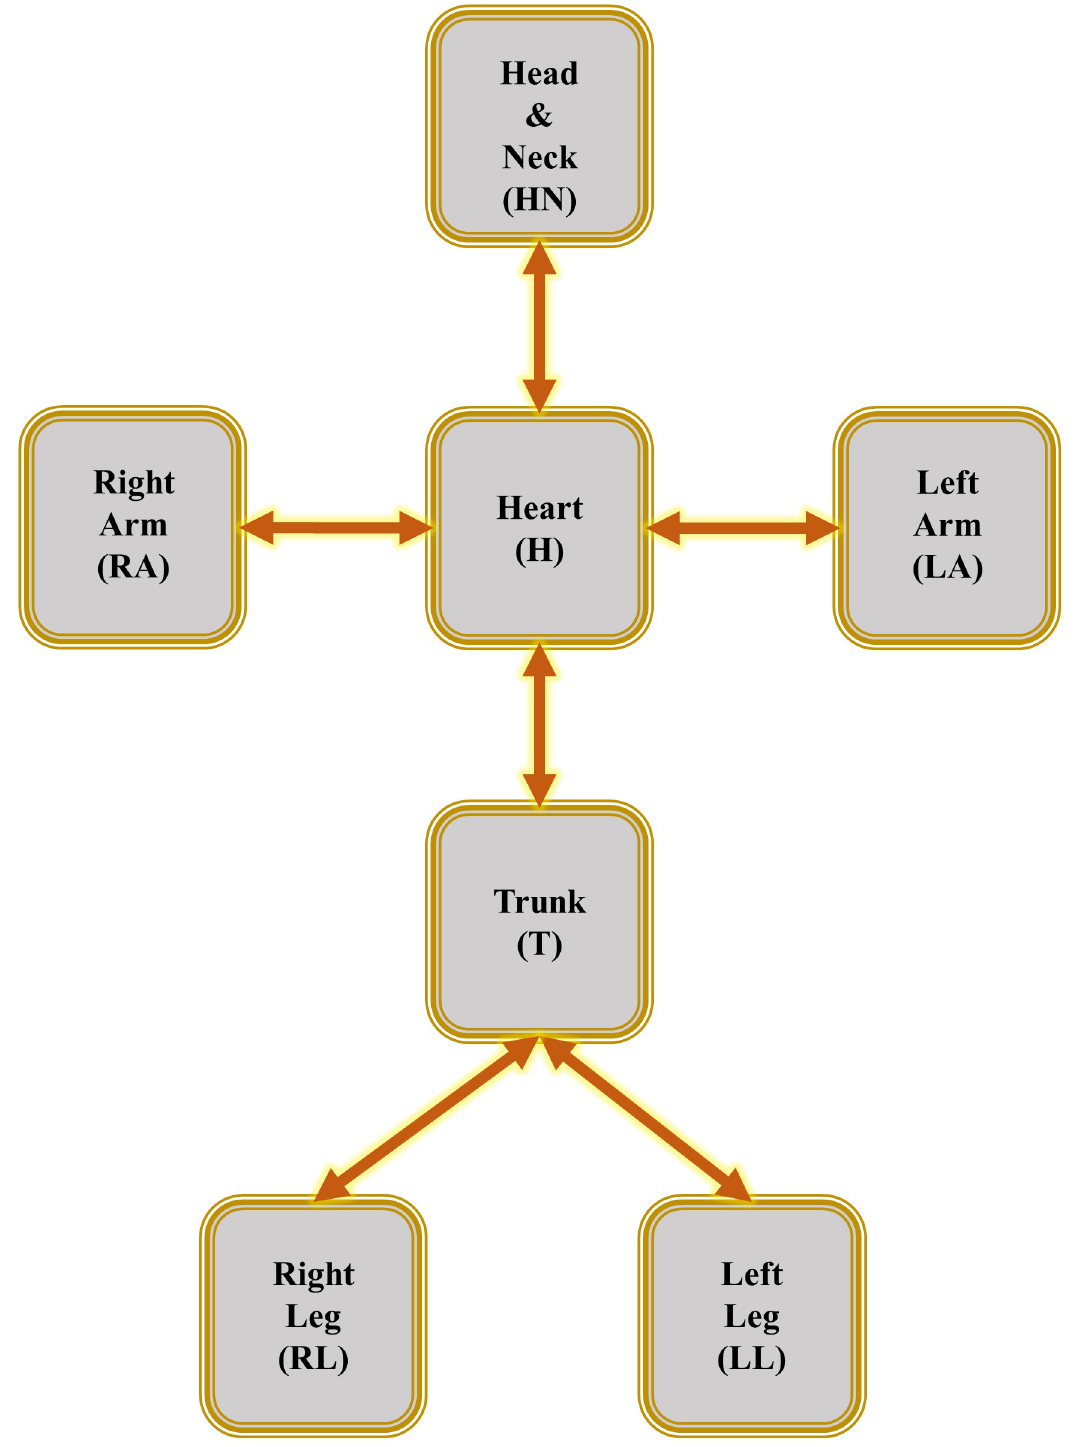
Fig 8. Lumped modules in the ADAN open-loop model. These lumped modules will be connected in the final step using the SemGen merger tool to produce the whole ADAN open-loop model.